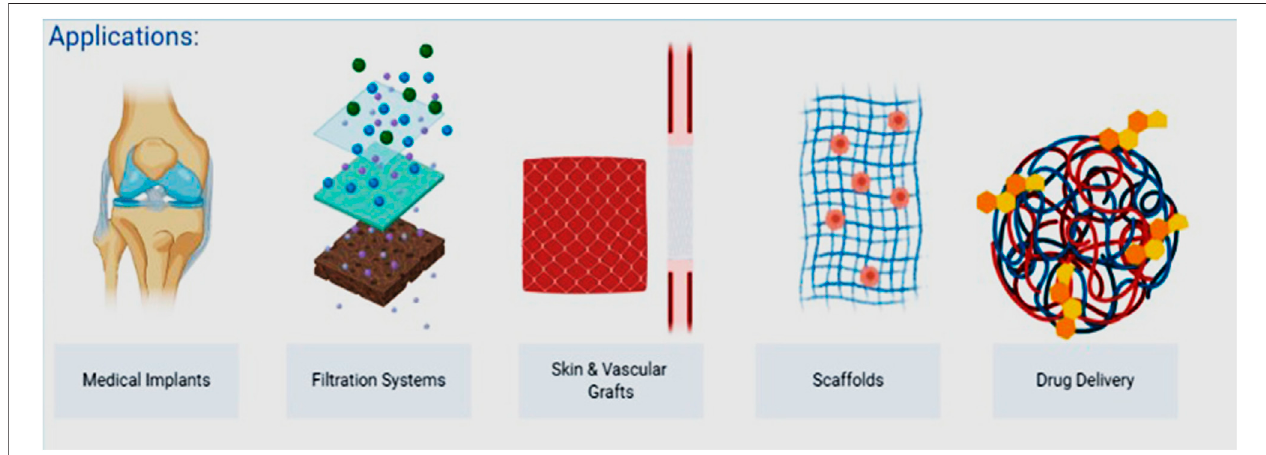
FIGURE 8 | An overview of BNC implants used in tissue restoration and regrowth reprinted with permission from Swingler et al. (2021) under Creative Commons Attribution License (CC BY).